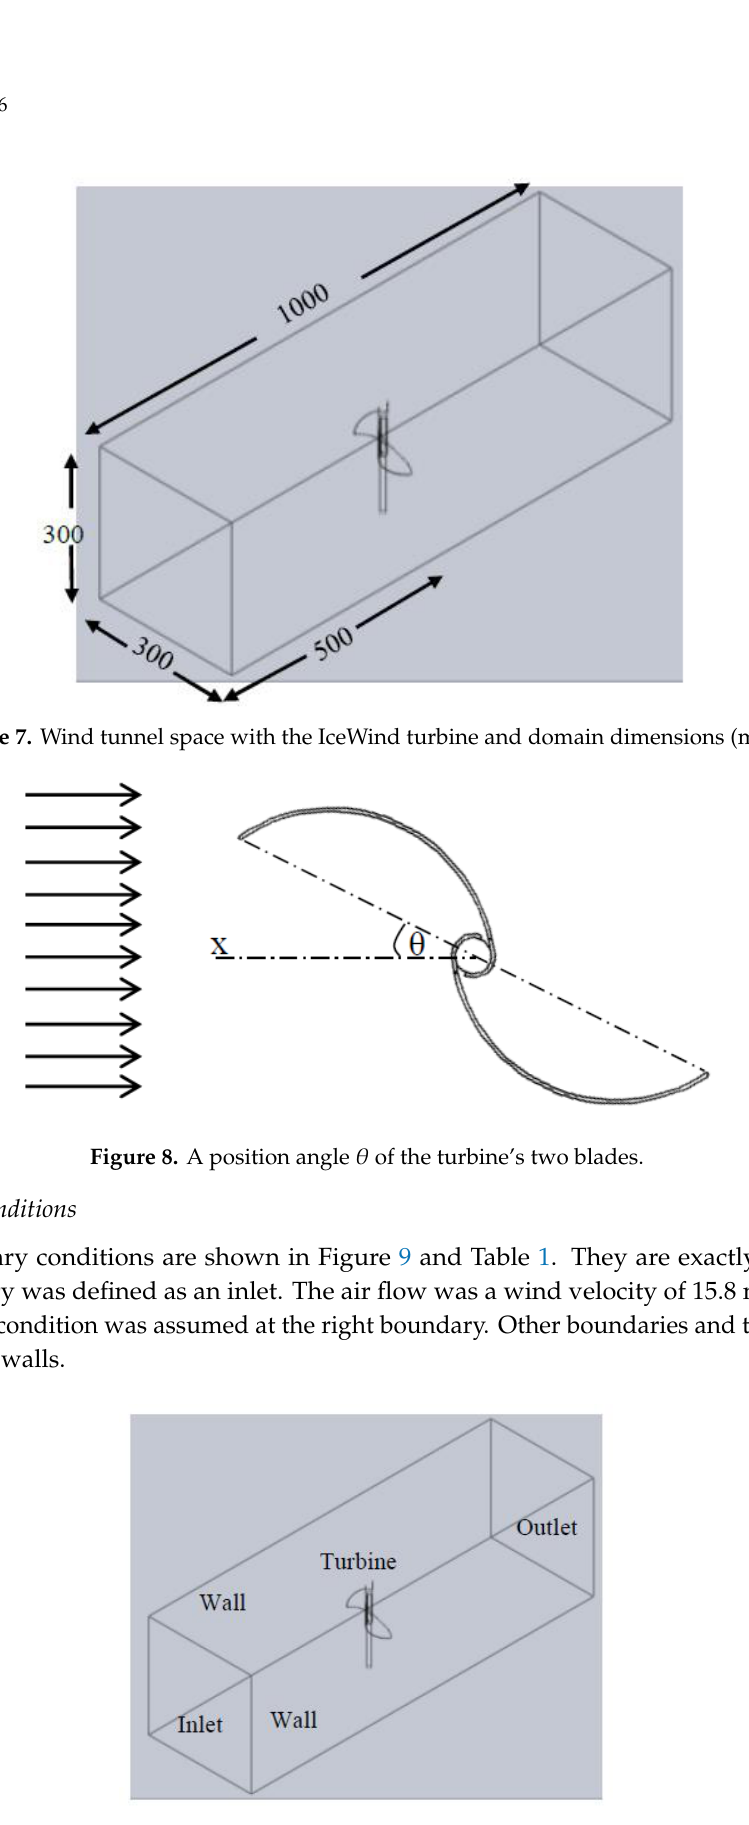
Figure 9. Boundary conditions. Figure 9. Boundary Table 1. Boundary conditions.